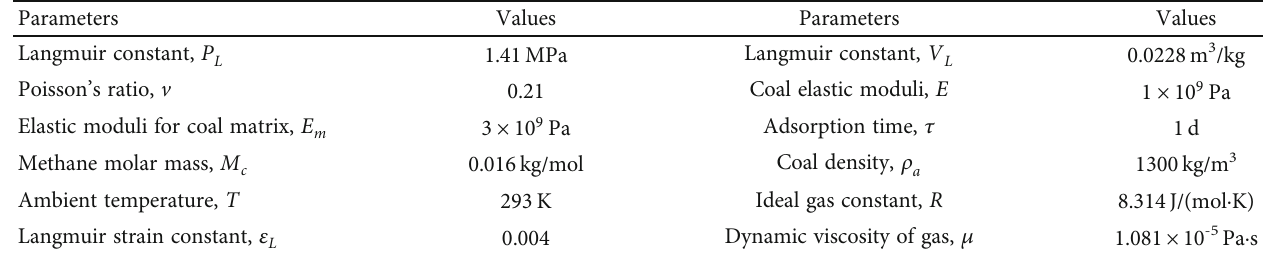
Table 4: Calculation parameters for gas extraction